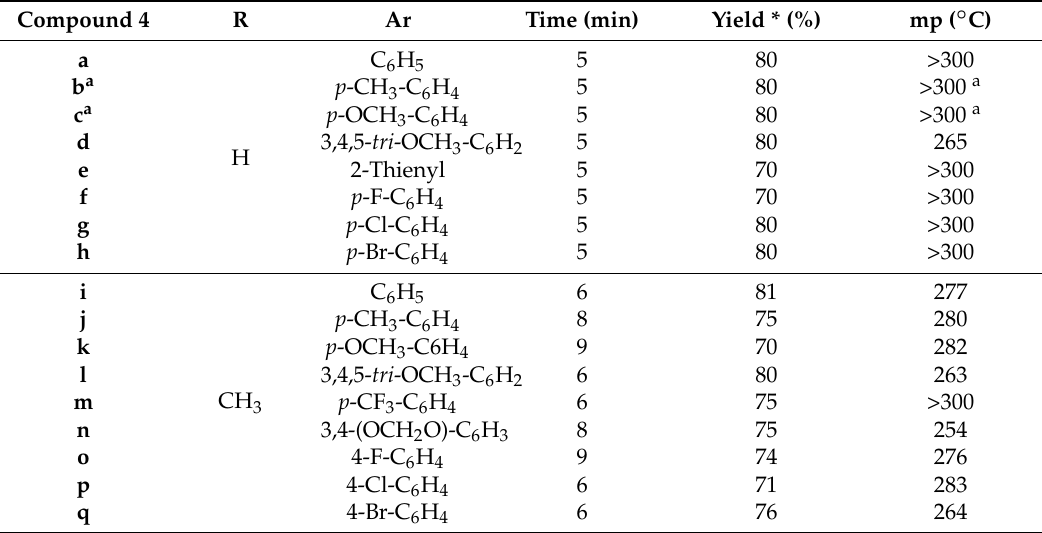
Table 2. Results of microwave (MW)-assisted synthesis of 4a – q compounds, in solvent/catalyst-free conditions.